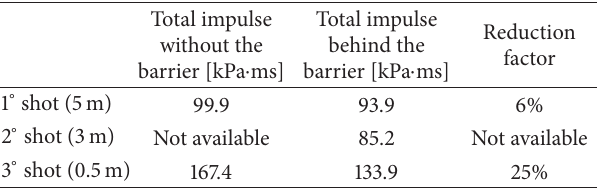
Table 5: Experimental total impulse and relative reduction